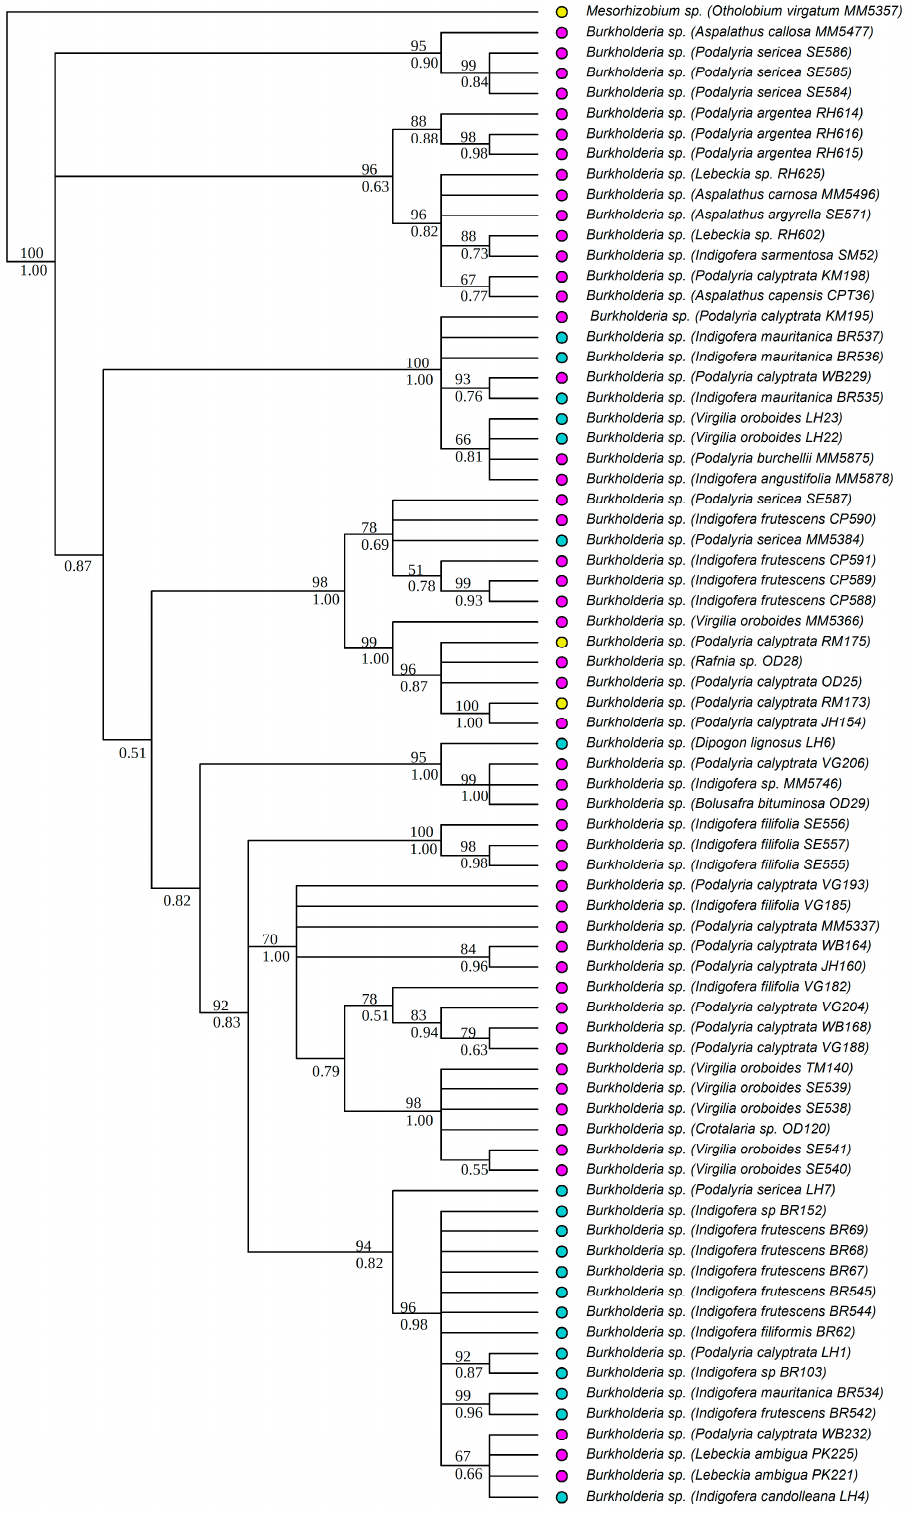
Figure 3. Phylogenetic relationships of Burkholderia strains based on N-acyltransferase ( nodA ) data. Names of the legume hosts and rhizobial strain numbers are in parentheses. Strain numbers with the prefixes OD- and MM- are from the study by Lemaire and co-workers [21]. The rest were newly generated in this study. ML bootstrap (%) and BI posterior probabilities are shown above and below nodes, respectively. Colored circles indicate the soil types of the sites where the legumes and their symbionts were collected, blue: granite; pink: sandstone, yellow: shale.